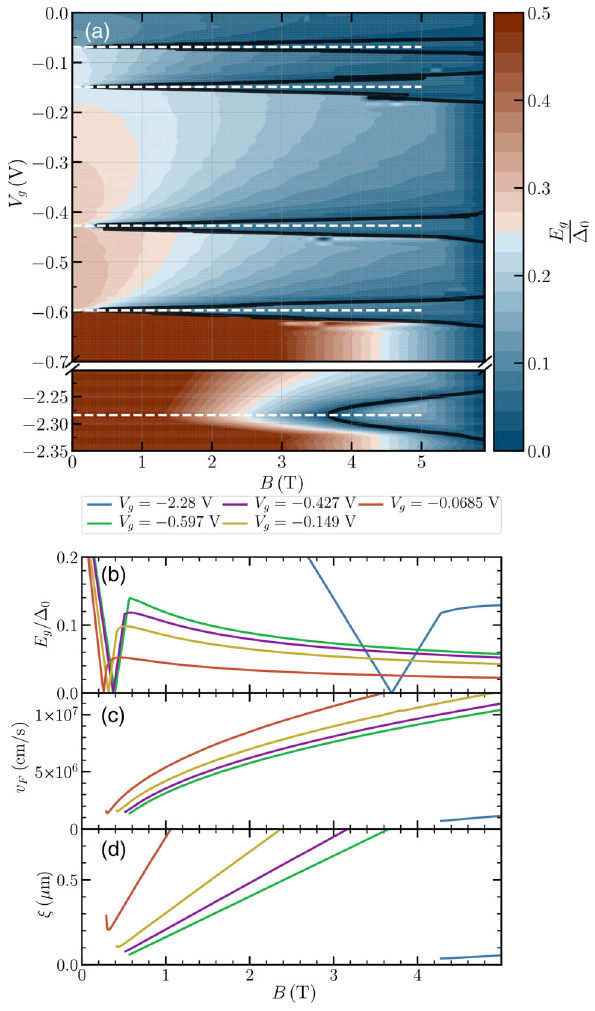
FIG. 12. (a) Topological phase diagram and magnitude of the spectral gap over a range of gate voltages from zero to very strongly negative. Clearly, the gap at zero field is largest for negative gate voltages where hybridization with the Al shell is strongest. The boundaries of the topological phase are marked with solid black lines. Dependence of the (b) gap normalized to = Δ 0 and estimates for (c) Fermi velocity and the bare Al gap E g (d) coherence length as a function of magnetic field for the gate voltages indicated by dashed lines in